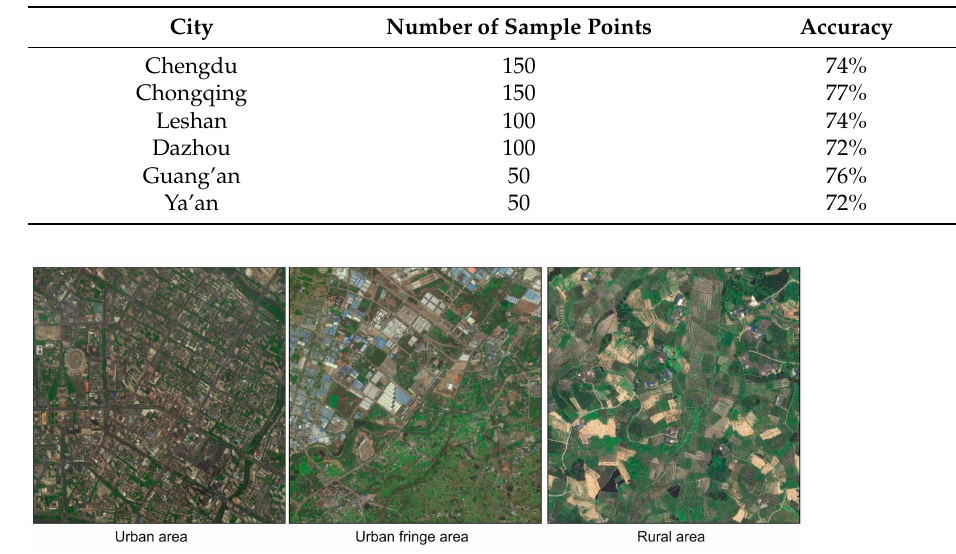
Table 6. Verification results of remote sensing images.